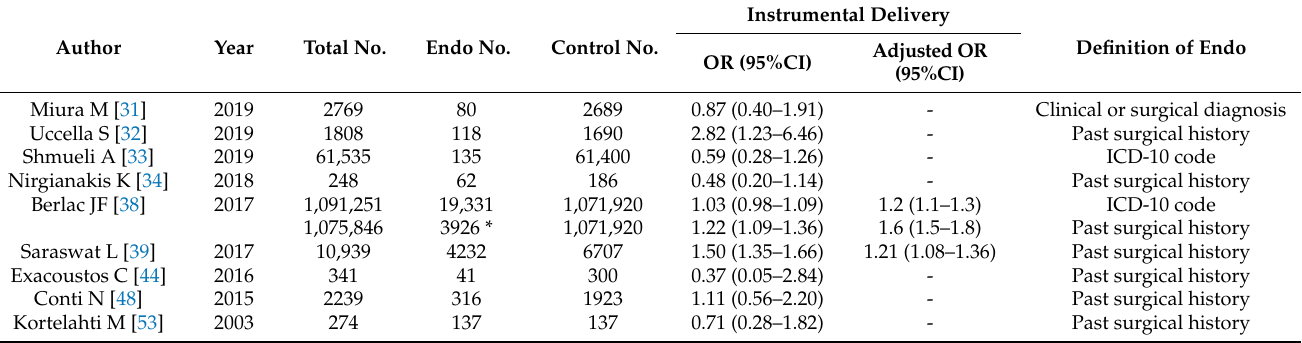
Table 1. Comparator analysis of the rates of instrumental delivery between women with and with- out endometriosis.